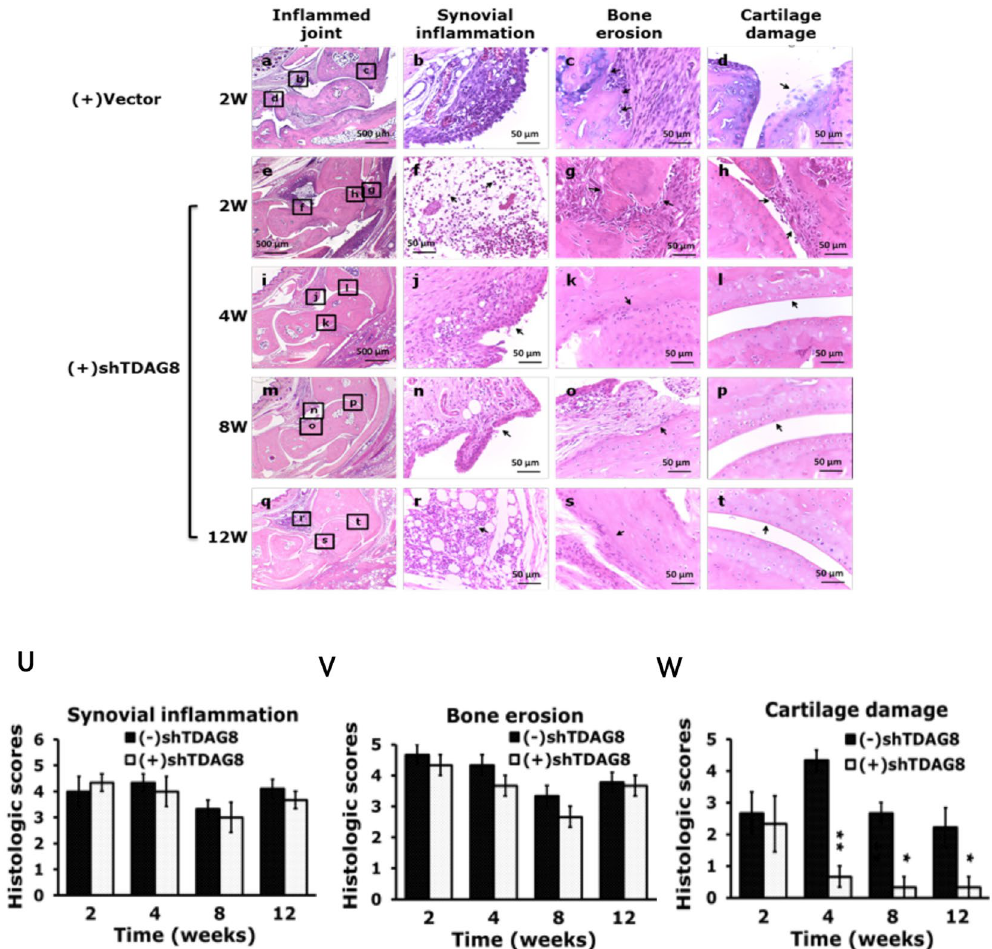
Figure 6. Histology of ipsilateral joints in Arthritic TDAG8 knockdown mice. Samples of joints from shTDAG knockdown mice at 0, 4, 8, 12 weeks stained with hematoxylin and eosin are shown in (a-t). Data are mean ± SEM severity score for pannus (U), bone erosion (V), and cartilage damage (W). * p < 0.05, ** P < 0.01, comparing ( + )shTDAG8 vs ( − )shTDAG8 by nonparametric Mann-Whitney U